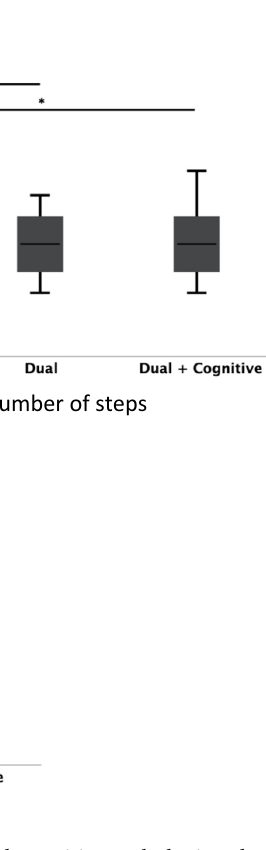
Figure 5. Turning parameters for the three conditions: single task, dual task, and dual and cognitive task during the ITUG test. * Significant differences for pairwise comparisons.